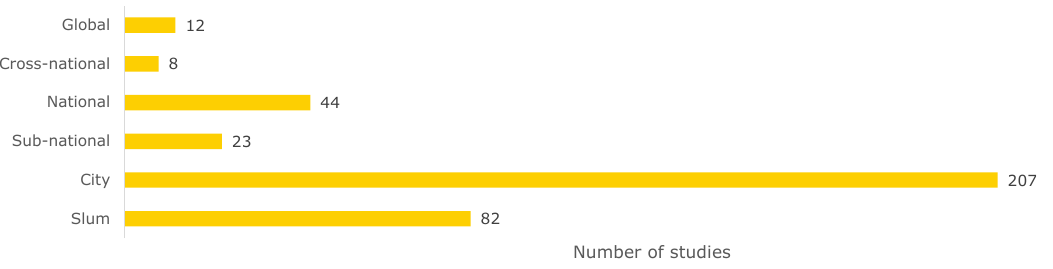
Figure 6. Number of studies on slum health per geographical